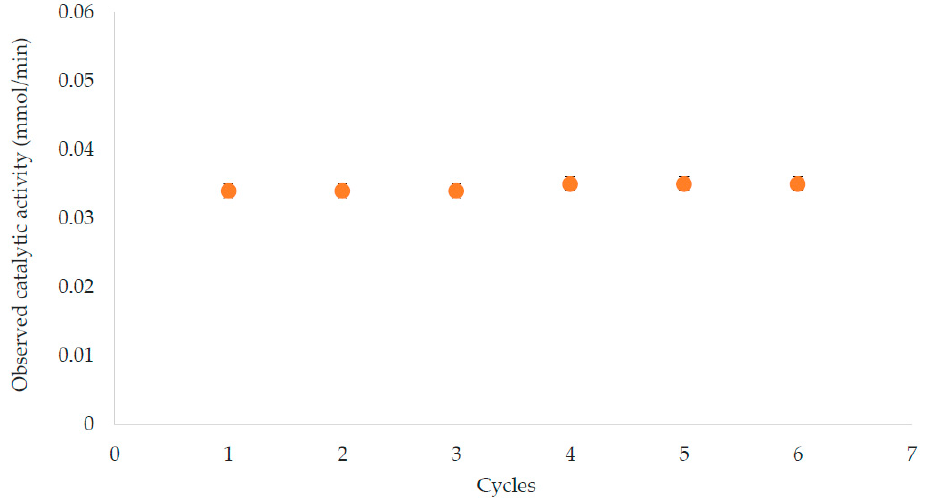
Figure 4. Observed catalytic activity of immobilized lipase after different reaction cycles.